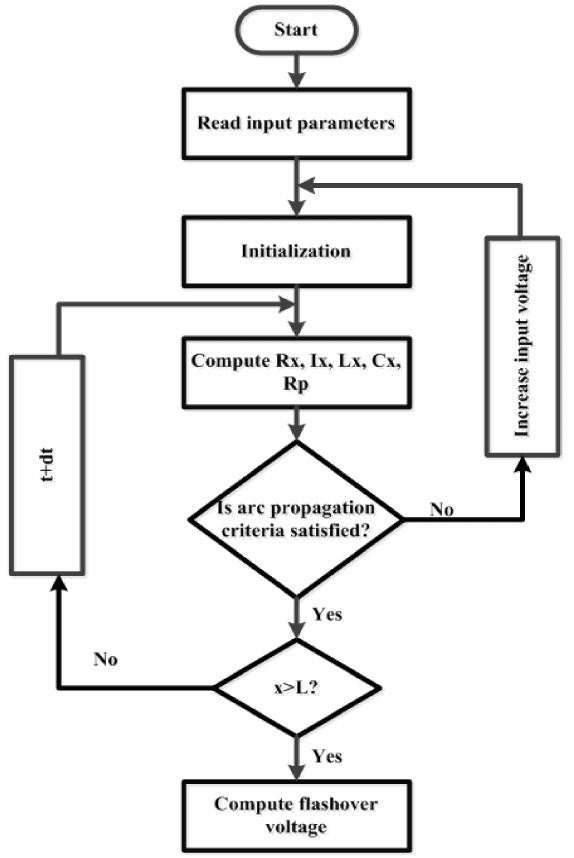
Figure 14. Flow chart of flashover voltage